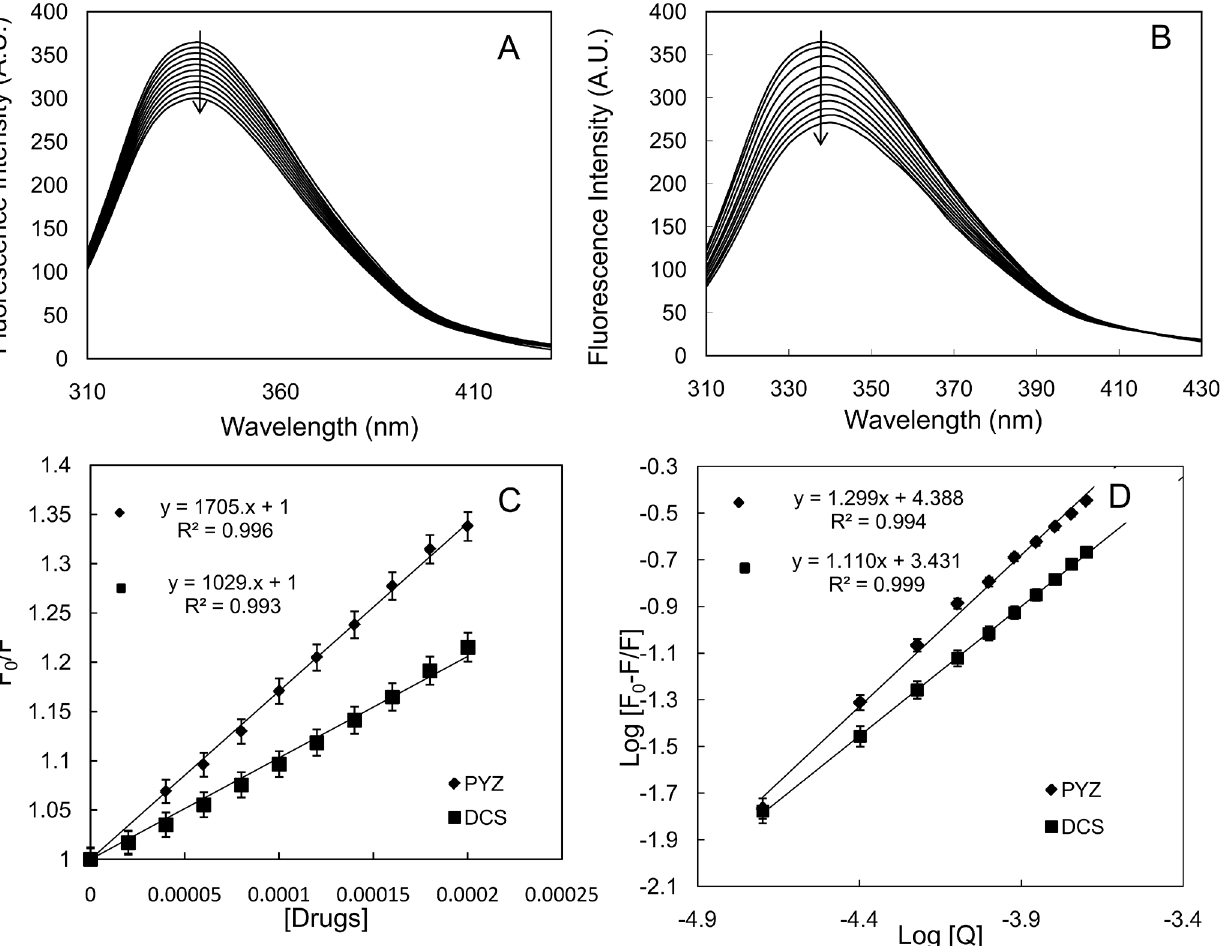
Fig 8. Steady-state fluorescence quenching measurements of HEWL in presence of DCS and PYZ. (A) Fluorescence spectra of HEWL (5 μ M) in presence of DCS (0 – 200 μ M) (B) Fluorescence spectra of HEWL in presence of PYZ (0 – 200 μ M) (C) Stern-Volmer curve of HEWL in presence of DCS and PYZ. (D) Modified Stern-Volmer curve of HEWL in presence of DCS and PYZ.